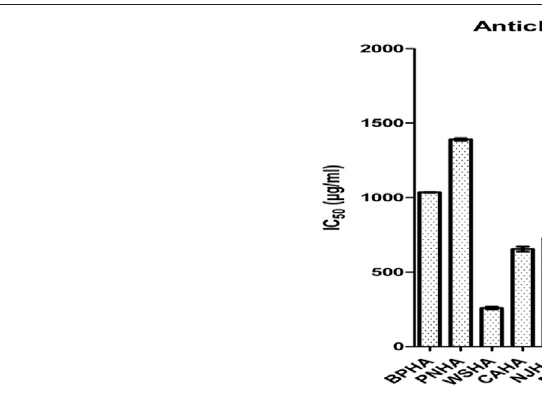
FIGURE 1 | Anticholinesterase activity measured as IC50 value of selected plant